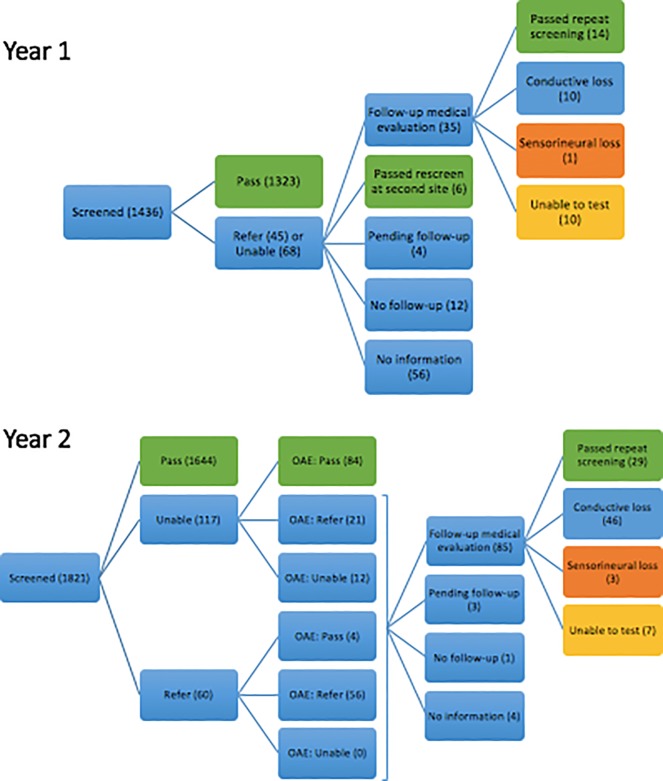
Flowchart of screening outcomes, year 1 (2014–2015) and year 2 (2015–2016).Children who ultimately passed their hearing screening are highlighted in green outcome boxes. Those diagnosed with sensorineural hearing loss are marked in orange boxes.